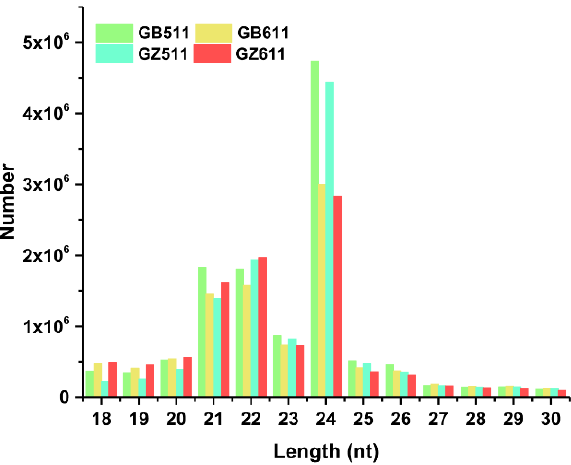
Figure 1. Length distribution of sRNAs in E. ulmoides